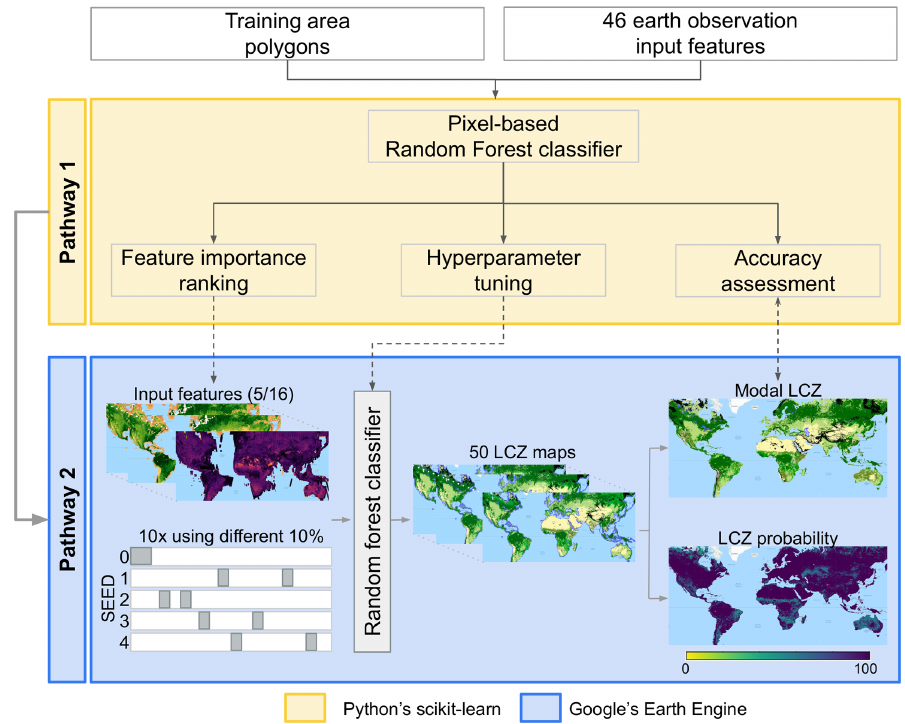
Figure 2. Schematic representation of the sequential pathways to develop the global LCZ map.